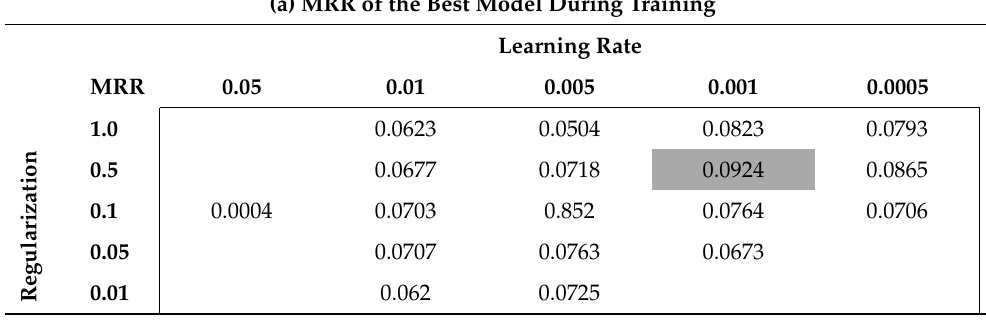
Table 3. Evaluation of different combinations of the learning rate and regularization parameters, using the MRR value as a benchmark. The first table shows the MRR of the best model during the training phase. The second table shows the MRR obtained by the best model on the test set. (a) MRR of the Best Model During